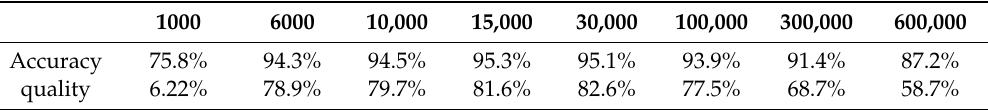
Table 2. The results of different sizes of training samples.